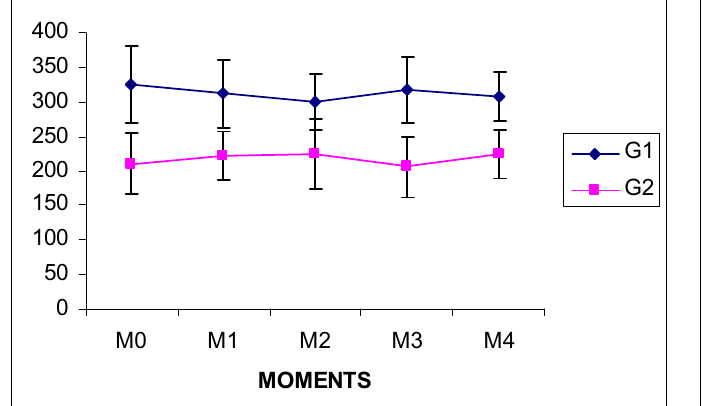
FIGURE 3 - Mean values for hydroxyproline concentration (µg/100 mg of tissue) of samples for the ileal segment in the two groups at the experimental moments